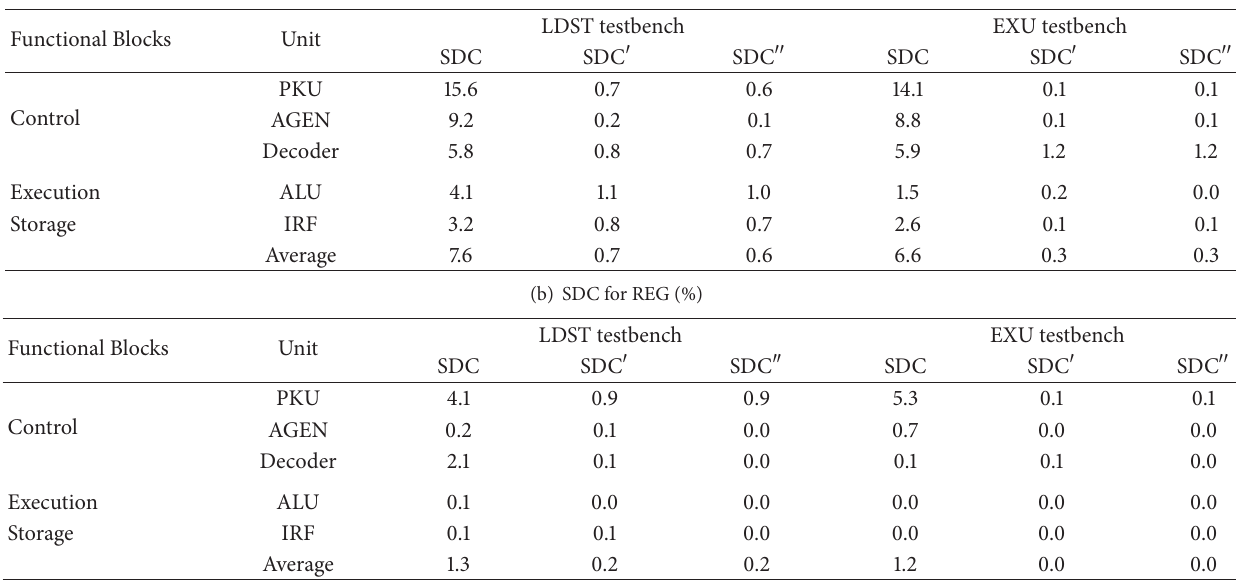
Table 10: SDC ((a) for NET and (b) for REG).